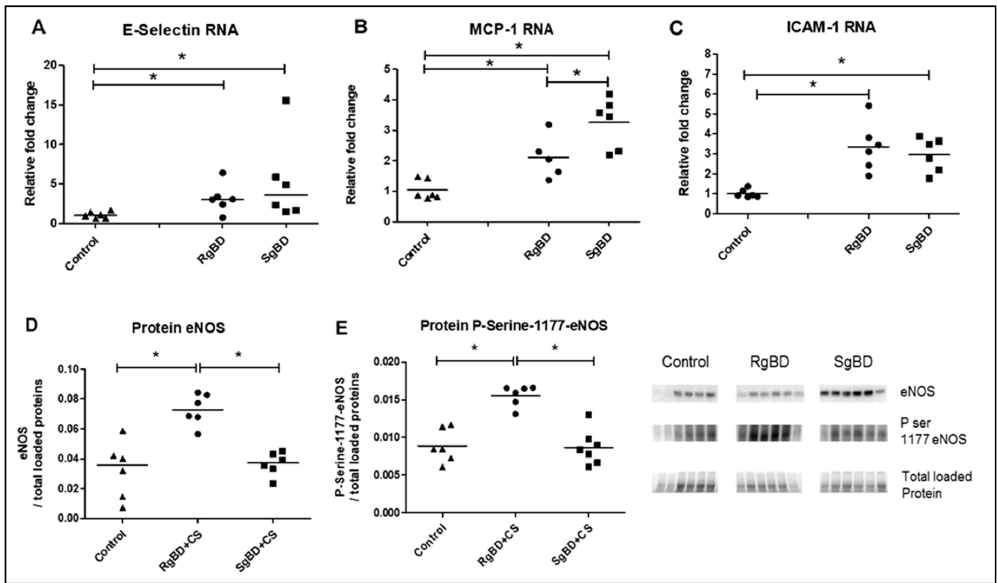
Figure 5. Donor management: Endothelial activation; genomic expression of adherence molecules and protein expression of endothelial nitric oxide synthase (eNOS) and P-Serine-1177-eNOS at end of reanimation. RNA expression level of E-Selectin ( A ), CCL2/MCP-1 ( B ) and ICAM-1 ( C ), and protein expression level, by western blot, of eNOS ( D ) and ratio Serine 1177 phosphorylated eNOS to eNOS total ( E ) evaluated in renal tissue of rapid brain death induction (RgBD) and slow brain death